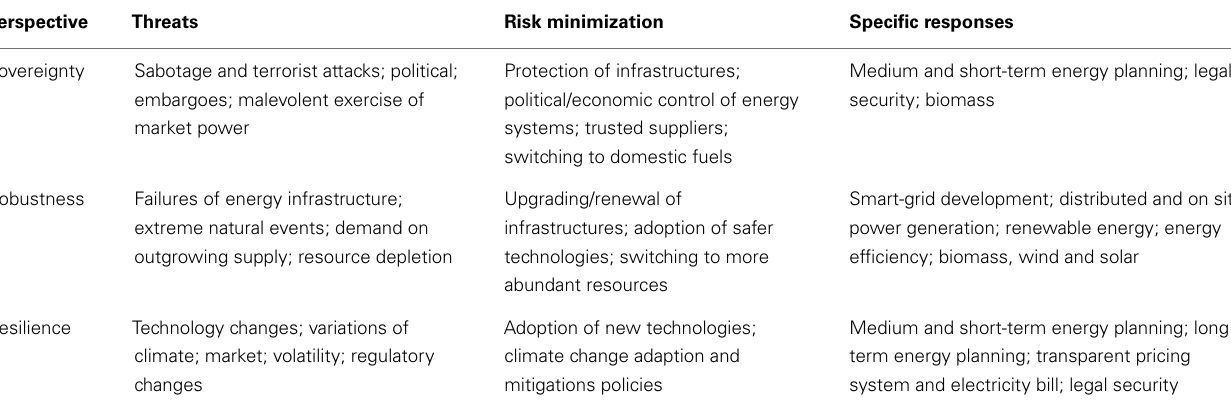
Table 2 | Perspectives on energy security and options to improve sovereignty, robustness, and resilience for the Catalan case study [adapted from Figure 1 (Cherp and Jewell, 2011)]